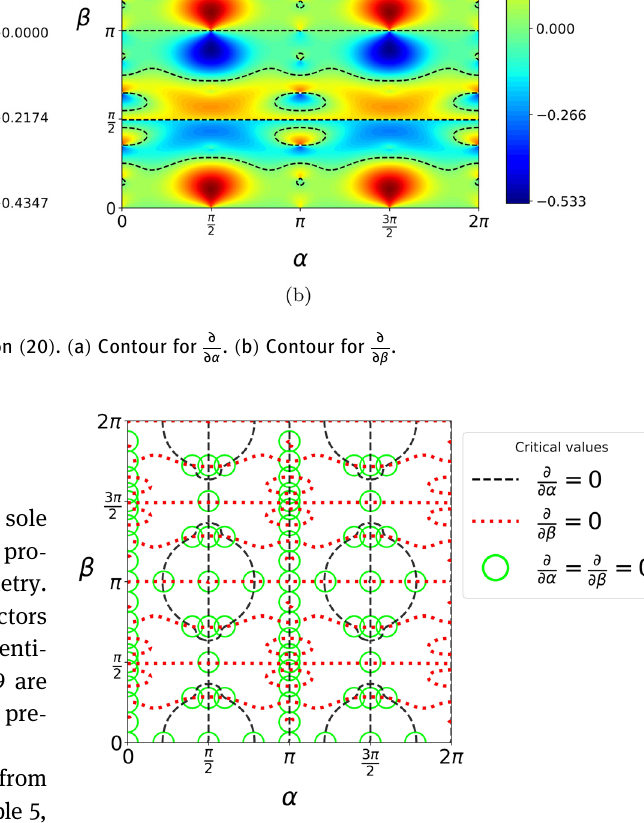
Figure 11: Graphs displaying the partial derivatives of equation ( 20 ) . ( a ) Contour for